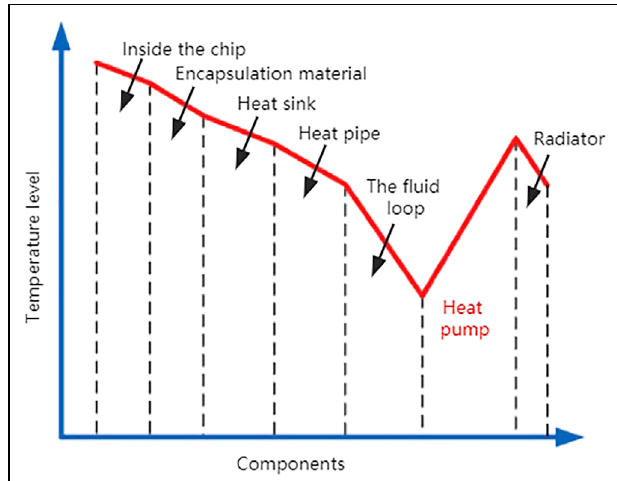
FIGURE 4 | Temperature level of each component of the thermal control system under heat pump